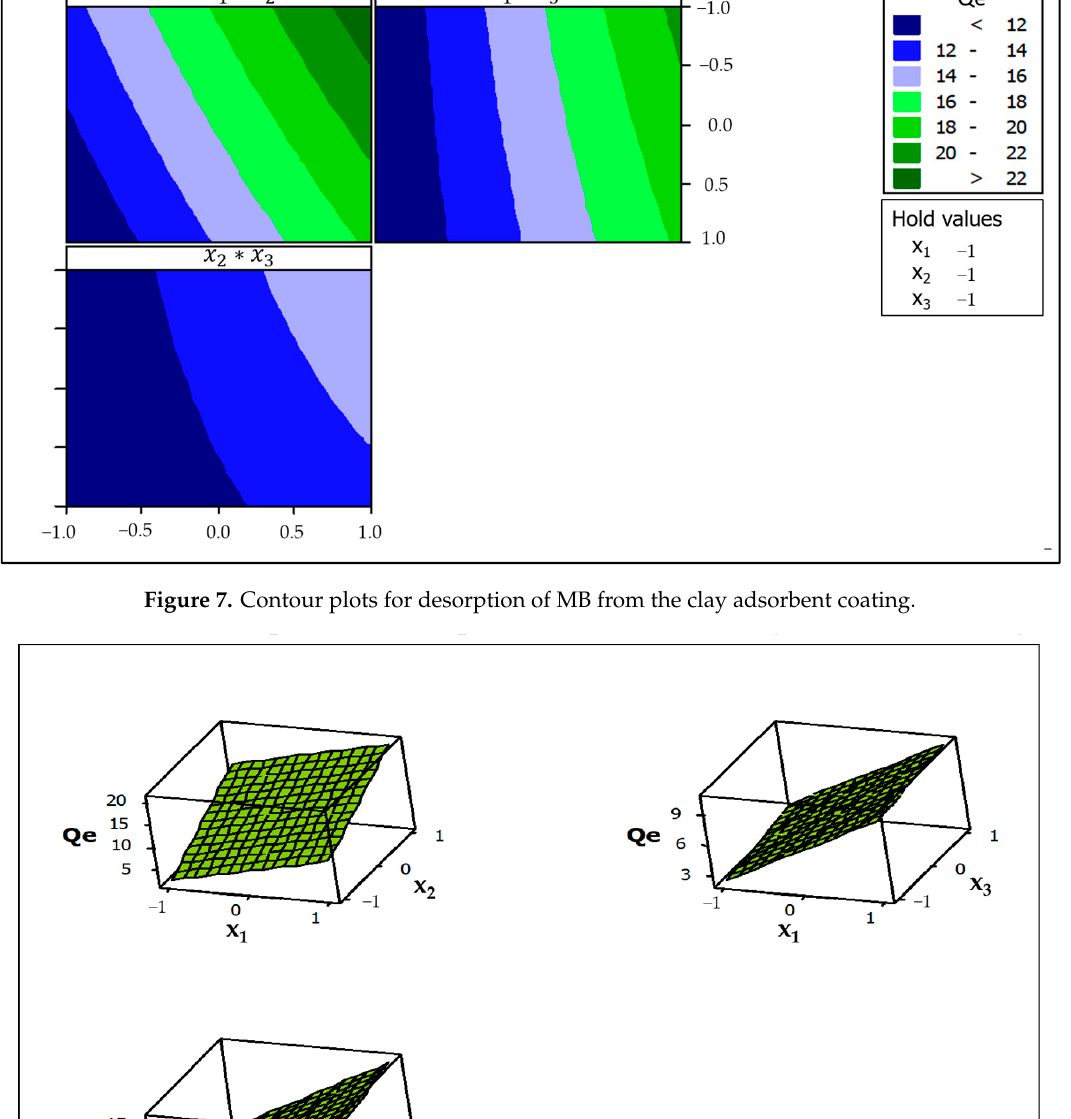
Figure 8. Response surface plots for desorption of MB from the clay adsorbent coating.